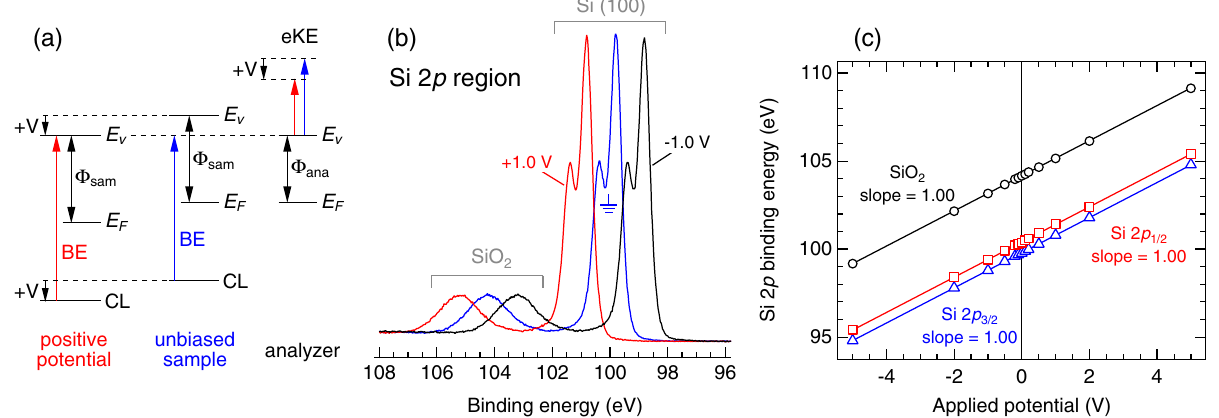
FIG. 1. Surface potential measurements by XPS. (a) Energy level diagram for the photoelectron process from an unbiased sample (blue) and from a sample under positive external potential (red). E F , Fermi level; E V , vacuum level; Φ , work function; sam, sample; ana, hemispherical energy analyzer; eKE, photoelectron kinetic energy; BE, binding energy; CL, core level; V, applied potential. A positive bias shifts all of the sample levels down with respect to those of the analyzer, having the effect of decreasing the kinetic energy of the outgoing photoelectron. (b) Si 2 p spectra from a SiO 2 = Si (100) substrate. Blue, grounded; red, positive (1 V) bias; black, negative ( − 1 V) bias. (c) Si 2 p BE as a function of applied